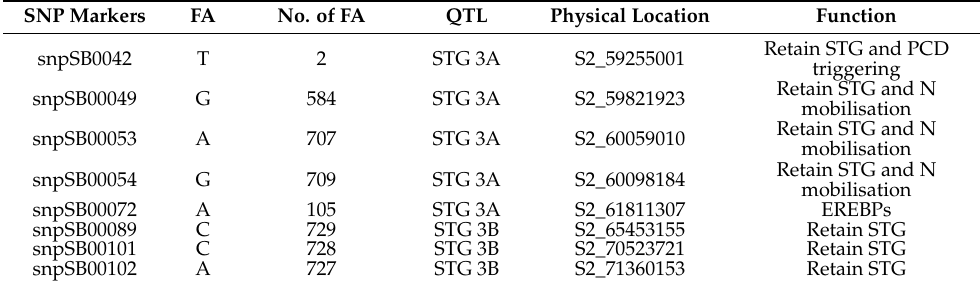
Table 6. Favourable alleles and STG QTLs identified in BC 2 F 3 populations of